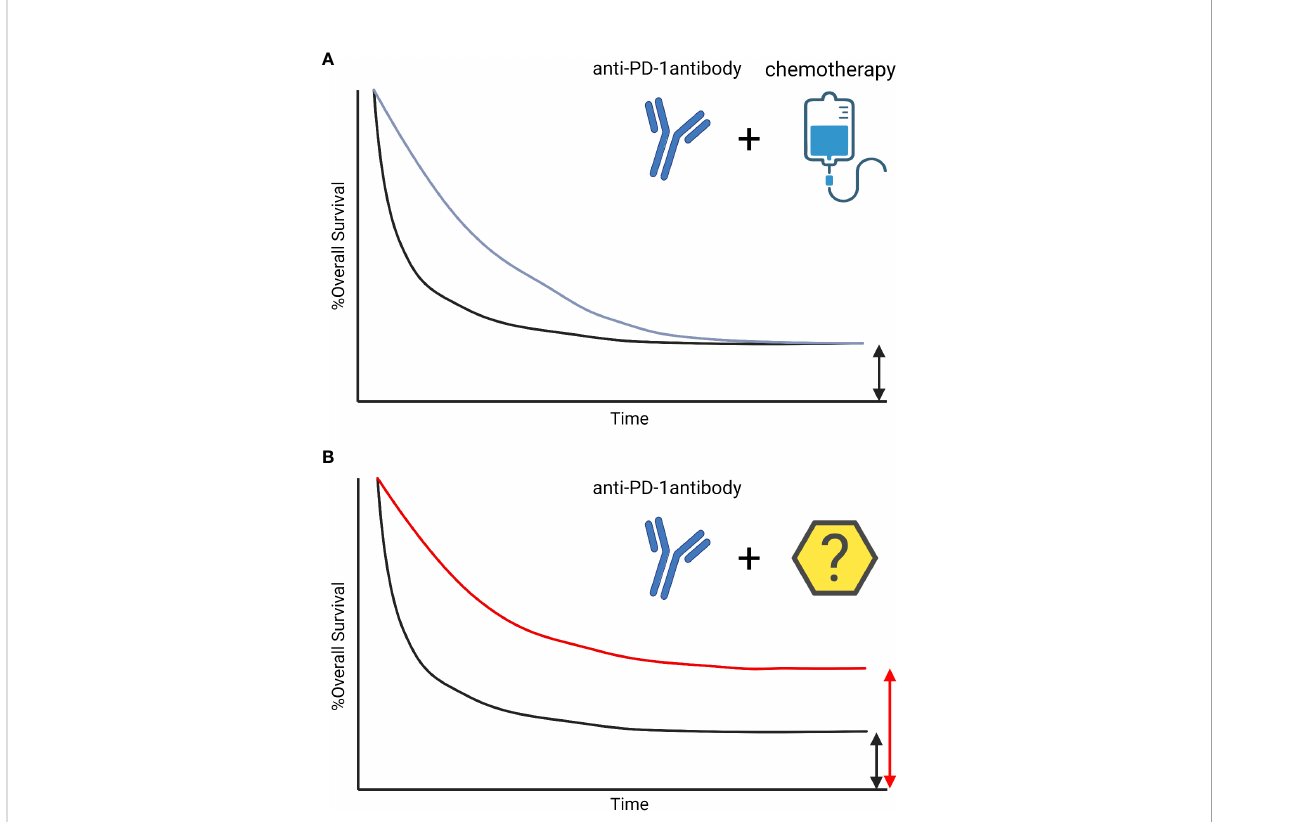
FIGURE 1 The survival curve of Immune-checkpoint inhibitors. The survival curve of Immune-checkpoint inhibitor (ICI) is characterized by patients with long-term response, called tail-plateau. The bene fi t of adding chemotherapies on ICIs are additive not synergistic. The combination therapies improved early-response, however, those did not lead to a sharp increase in survival after 3 years (1) (A) . Other treatment strategies with synergistic bene fi ts are needed to increase the number of patients with a long-term response (B)